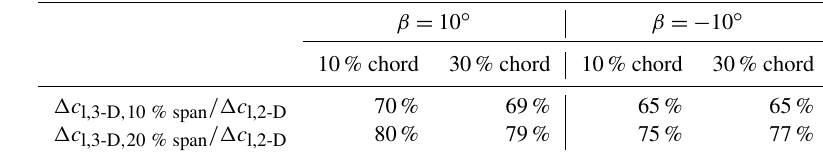
Table 6. c l amplitude, 75% blade cut, 15ms − 1 , steady deflections (Jost et al., 2016).